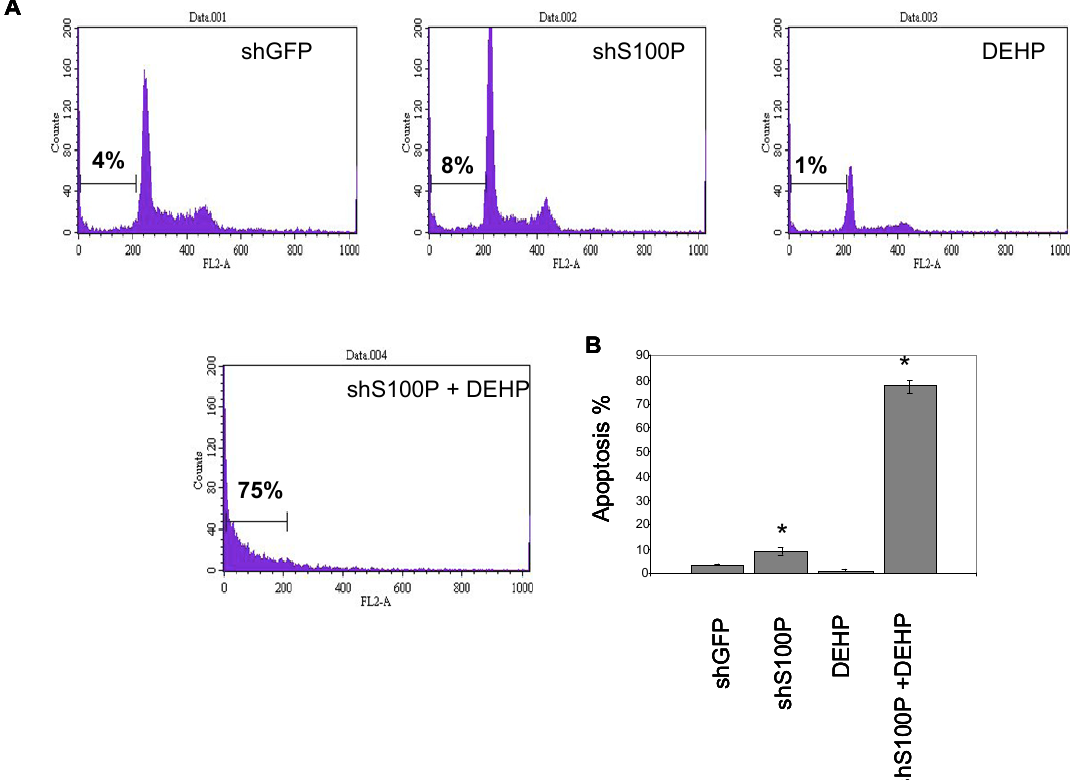
Figure 3. Representative apoptosis histograms of LN-229 cells exposed to DEHP alone and in combination with S100P knockdown. The percentage for apoptotic cells is shown. The changes in sub G1 DNA content were assessed by flow cytometric analysis. The experiments were repeated three times.